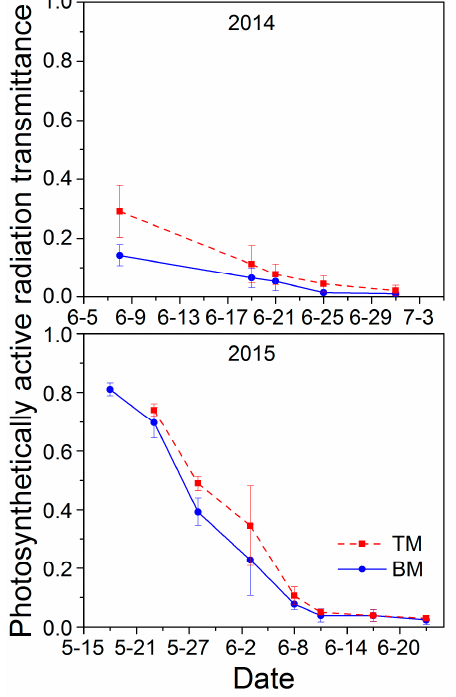
Figure 6. Photosynthetically active radiation transmittance of the transparent plastic film mulch (TM) treatment and black plastic film mulch (BM) treatment for potato production at Wuwei, China, in 2014 and 2015.